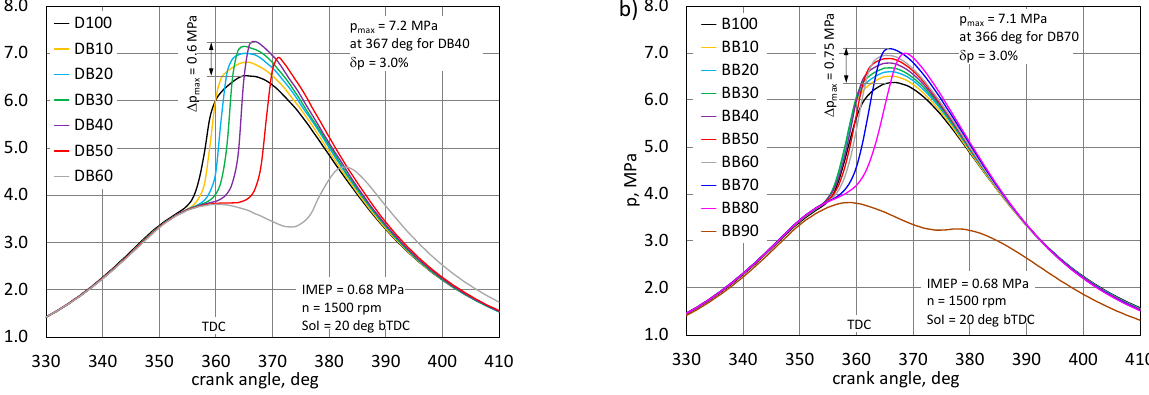
Figure 5. Comparison of the combustion pressure courses for an engine powered by a mixture of